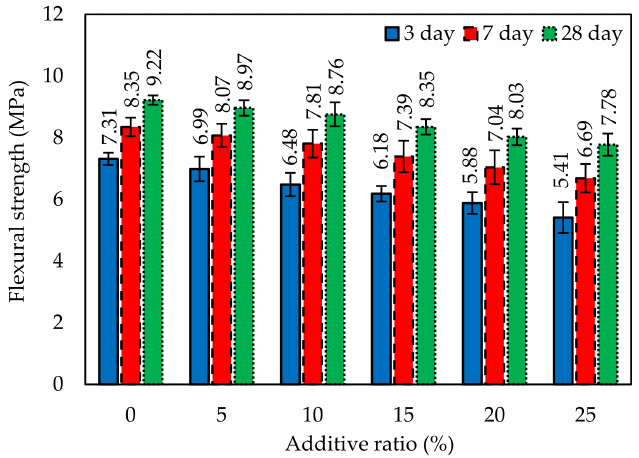
Figure 10. The flexural strength test results of cementitious composite mortars.